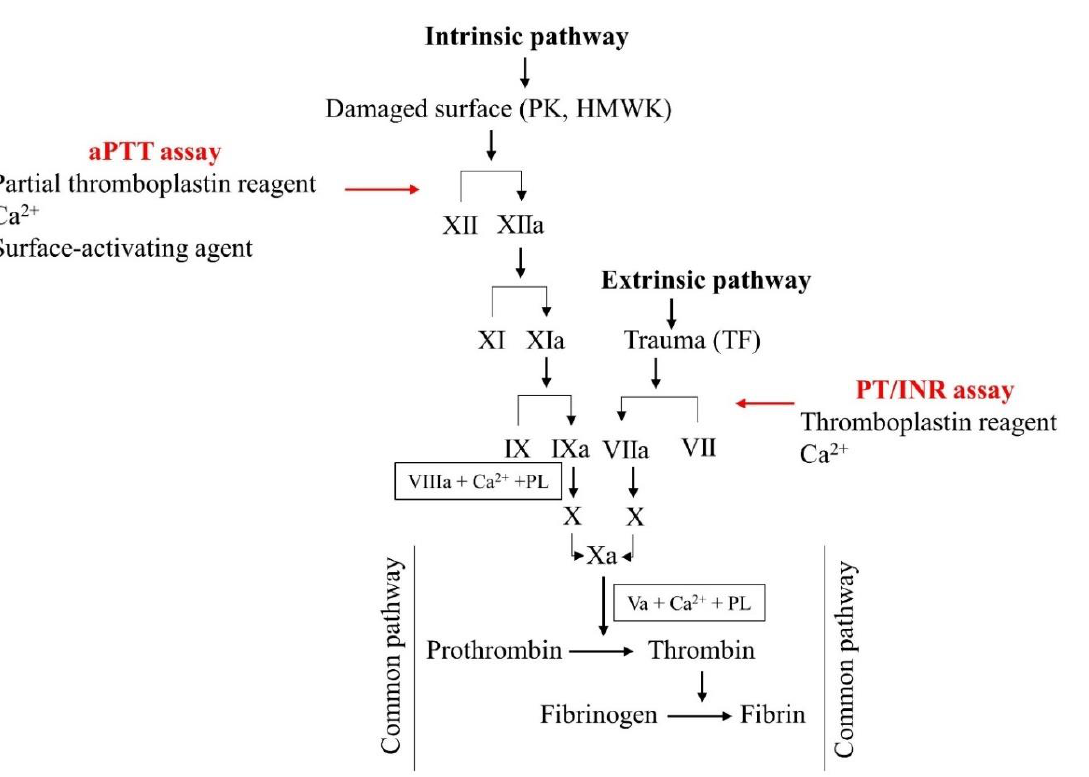
Figure 2. Intrinsic and extrinsic activator pathways.